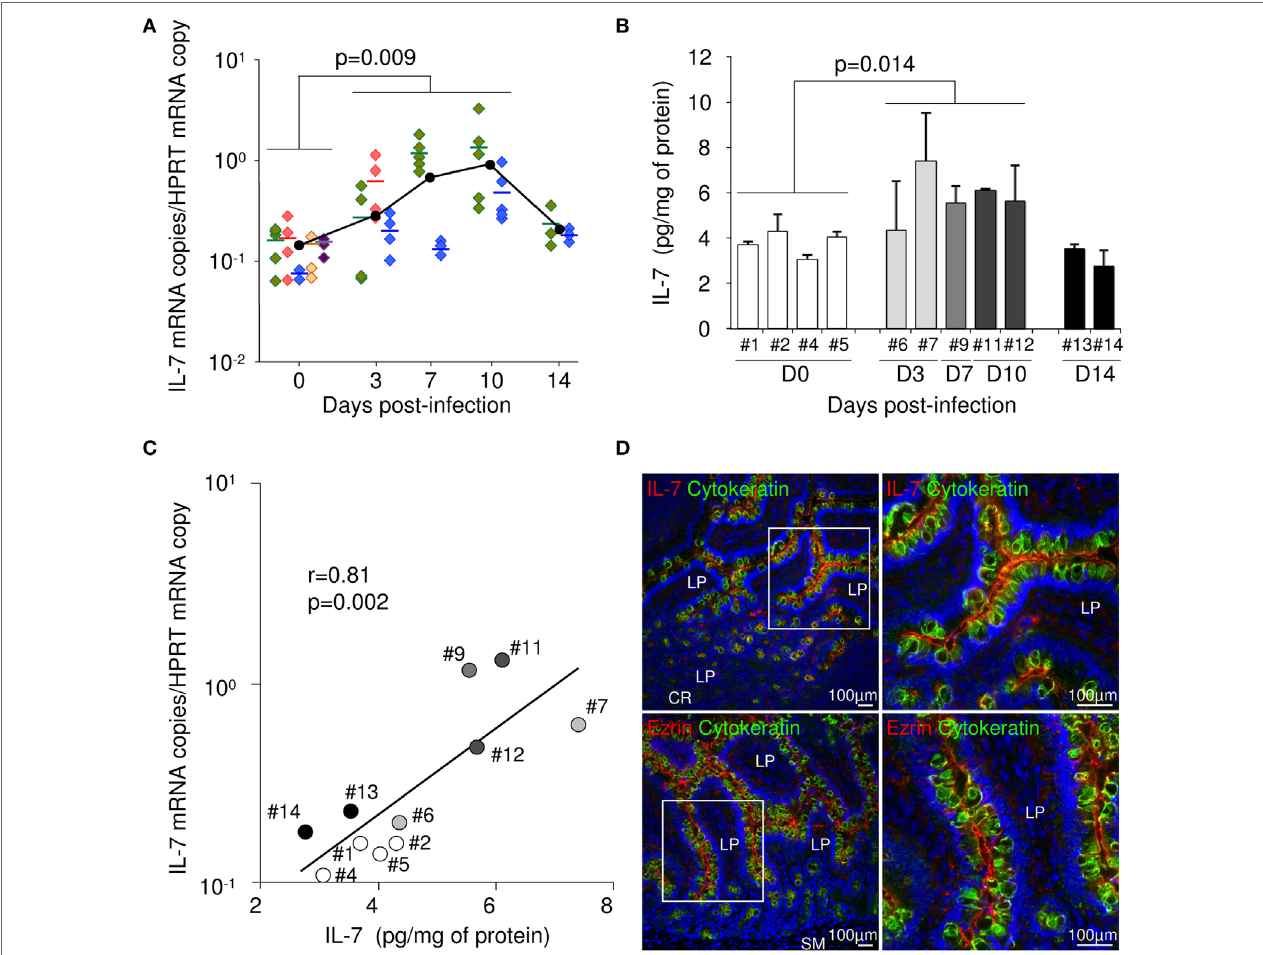
FigUre 1 | interleukin (il)-7 expression in the ileum of rhesus macaques during acute simian immunodeficiency virus (siV) infection . (a) IL-7 mRNA concentration in the ileum was quantified by RT-qPCR in healthy macaques (#1 green, #2 red, #3 blue, #4 brown, and #5 purple) and macaques sacrificed on days 3 (#6 green, #7 red, and #8 blue), 7 (#9 green and #10 blue), 10 (#11 green and #12 blue), or 14 (#13 green and #14 blue) following SIVmac 251 infection (IL-7 mRNA copies/HPRT mRNA copy). At each time point, each color represents one animal. For each macaque, each symbol represents an individual sample of ileal tissue, means are shown as horizontal bars. Black dots represent the median of the macaques sampled at each time point. Statistical significance between infected monkeys (days 3, 7, and 10) and healthy monkeys is shown; Mann–Whitney one-tail U test. (B) IL-7 concentration was assessed by ELISA in ileal tissue sampled from both healthy macaques and macaques sacrificed at days 3, 7, 10, or 14 following SIVmac 251 infection. Bars and error bars represent means and SDs, respectively. Statistical significance between pre- and post-infection samples is shown; Mann–Whitney one-tail U test. (c) Correlation between IL-7 concentration and IL-7 mRNA levels in ileal tissue sampled from healthy and SIV-infected macaques. Each point represents one animal. White circles represent uninfected controls; light gray, medium gray, dark gray, and black circles represent infected animals sampled at days 3, 7, 10, or 14, respectively. Regression line, Spearman’s rank correlation value, and associated probability are shown. (D) Immunohistofluorescent labeling for IL-7 (top panels; red) or Ezrin (bottom panels; red) and cytokeratin (all panels; green) on cryosections of ileal tissue sampled at day 10 pi. Right panels represent higher magnifications of squared areas on left panels. Nuclei are labeled in blue with DAPI. LP, lamina propria; SM, submucosa; CR,